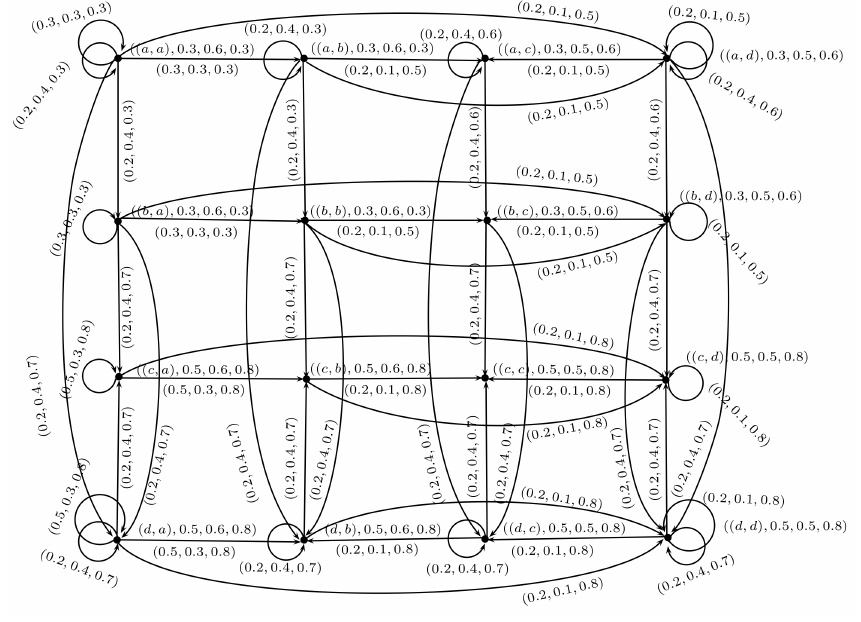
Figure 7. Neutrosophic digraph G 1 × G 2 = ( RN 1 × RN 2 , SE 1 × SE 2 )